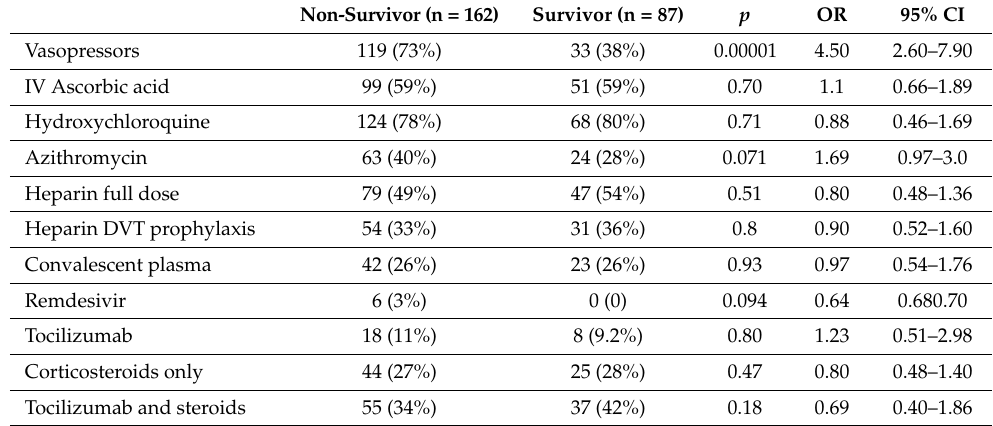
Table 8. Pharmacologic interventions in COVID-19 ICU survivors and